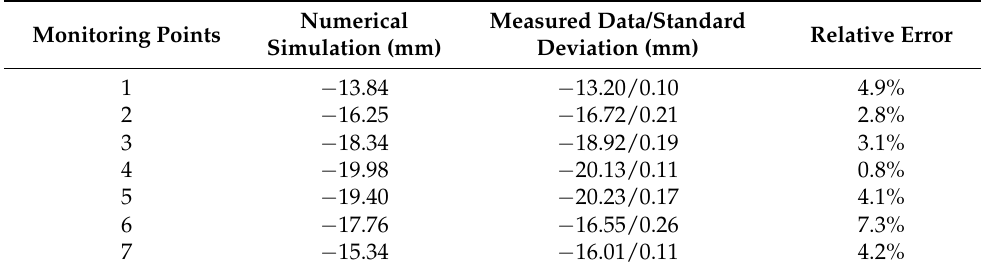
Figure 6. Comparison of measured surface settlement and numerical simulation results. Table 2. Comparison of measured and numerical simulation results at three sections.